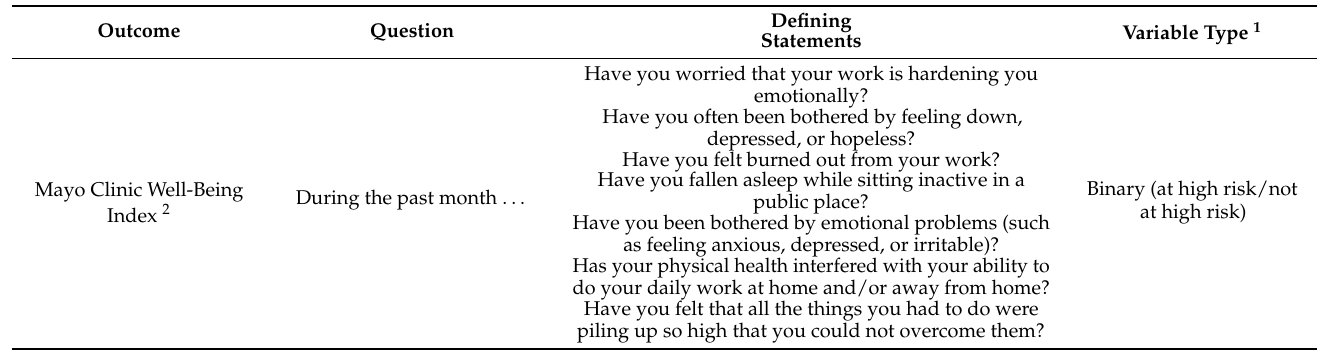
Table A1. Full description of questions selected to build the safety-related outcomes, with their respective defining statements and variable type, based on the PRICOV-19